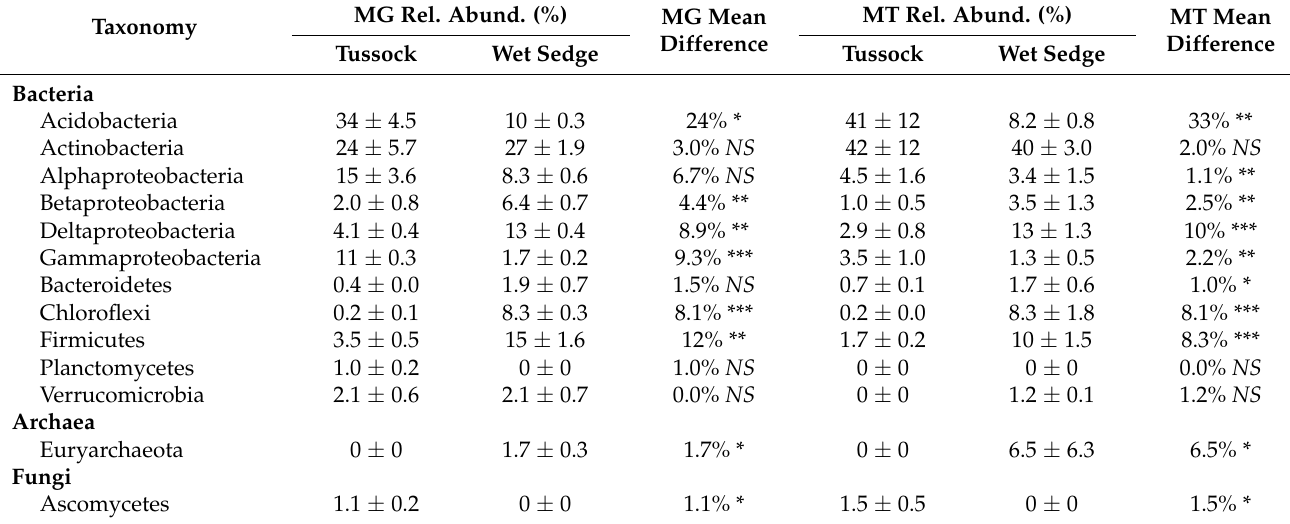
Table 3. Relative abundance calculated for tussock tundra and wet sedge tundra communities averaged across all sampling time points based on KEGG tier III “Ribosome” category from the GPM-normalized metagenome (MG) and TPM-normalized metatranscriptome (MT) datasets (mean ± SD). Asterisks indicate the significance of differences in mean pairwise similarity among tundra communities (paired t -test; *** p < 0.001, ** p < 0.01, * p < 0.05; NS = no statistically significant